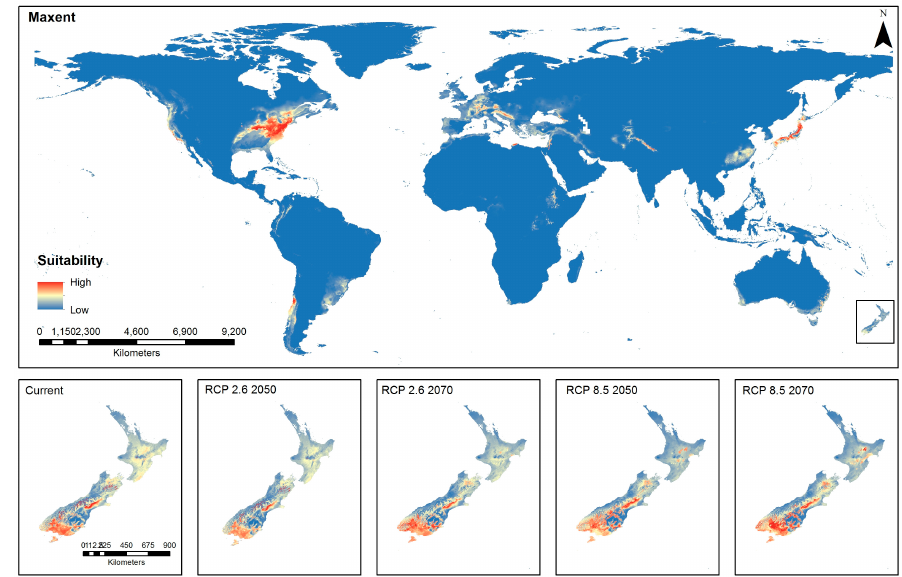
Figure 4. Global and New Zealand predictions of brown marmorated stink bug habitat suitability under current conditions and emissions trajectories of Representative Concentration Pathways (RCP) 2.6 and RCP 8.5 for the years 2050 and 2070 using Maxent algorithm.